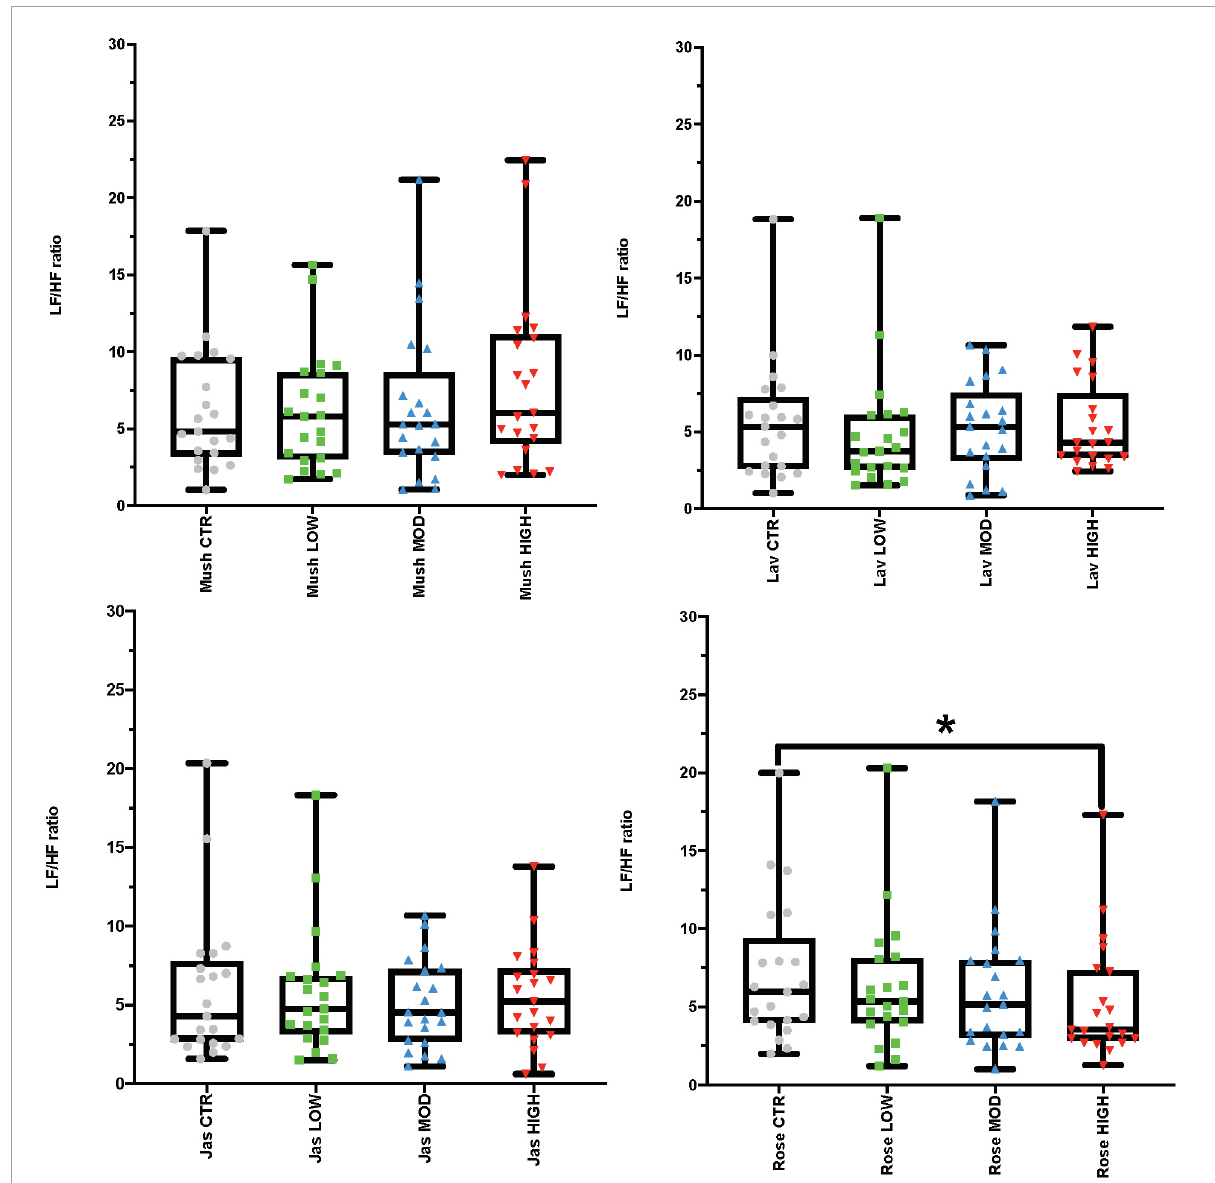
FIGURE2 Results from the inter-stimulus wash-out periods looking at the electrocardiogram (ECG) frequency-domain analysis representing low-high frequency (LF/HF) ratio values. Each graph in the compilation represents an odor (mushroom, lavender, jasmine, and rose) and all four concentrations (sham stimulation, low, moderate-mod, and high). * p -value < 0.05 from the post hoc Bonferroni pairwise comparisons between sham (CTR) and high